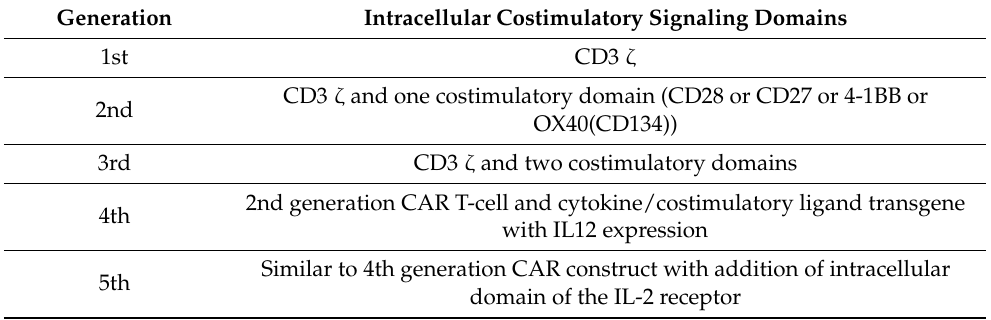
Table 1. Generations of chimeric antigen receptor T cells for acute lymphoblastic leukemia.